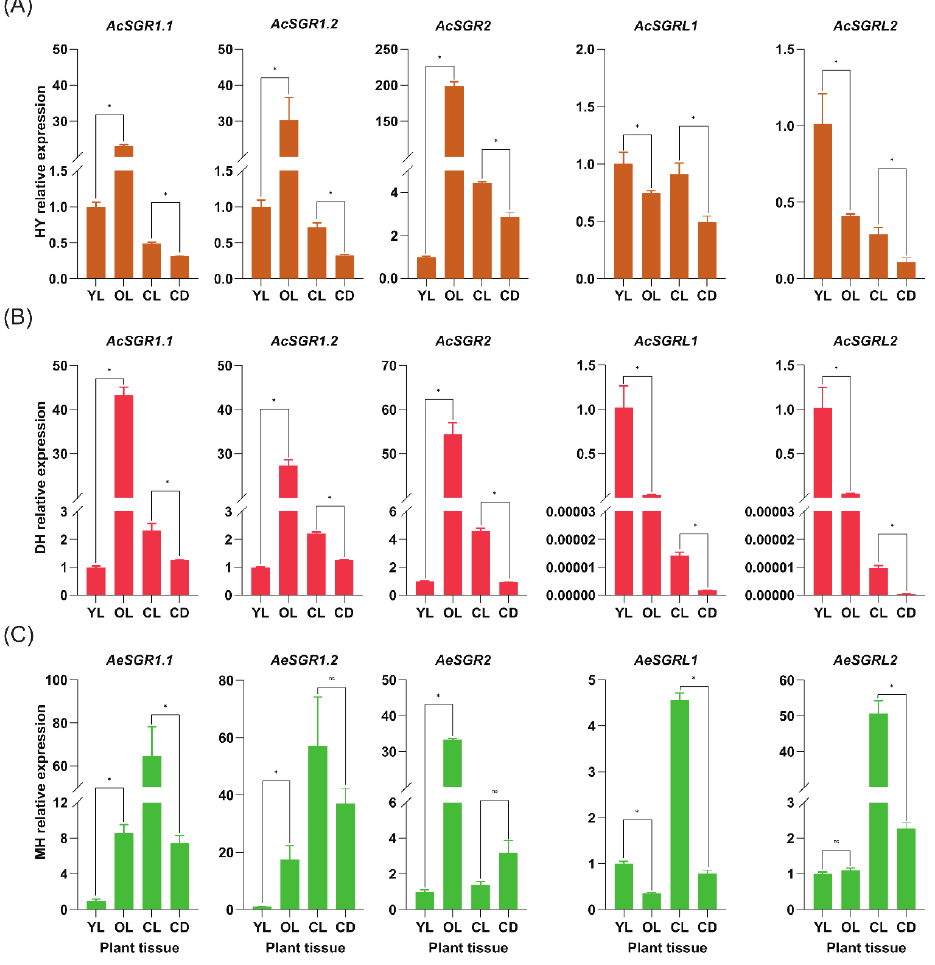
Figure 6. Expression profile analysis of AcSGR and AeSGR genes by using RT-qPCR in different plant tissues. Expression profile of SGRs ( A ) for HY, ( B ) for DH, and ( C ) for MH. The results were presented as the mean ± SD of three replicates. Actin was used as the internal standard for each gene, and the 2 − ∆∆ Ct method was used to calculate the relative expression of candidate genes. “*” indicated significant differences at p < 0.05, and “ns” indicated non-significant differences at p > 0.05. OL, old leaves; YL, young leaves; CD, callus tissues under dark condition; CL, callus tissues under light condition; DH, ‘Donghong’; HY, ‘Hongyang’; MH, ‘Maohua